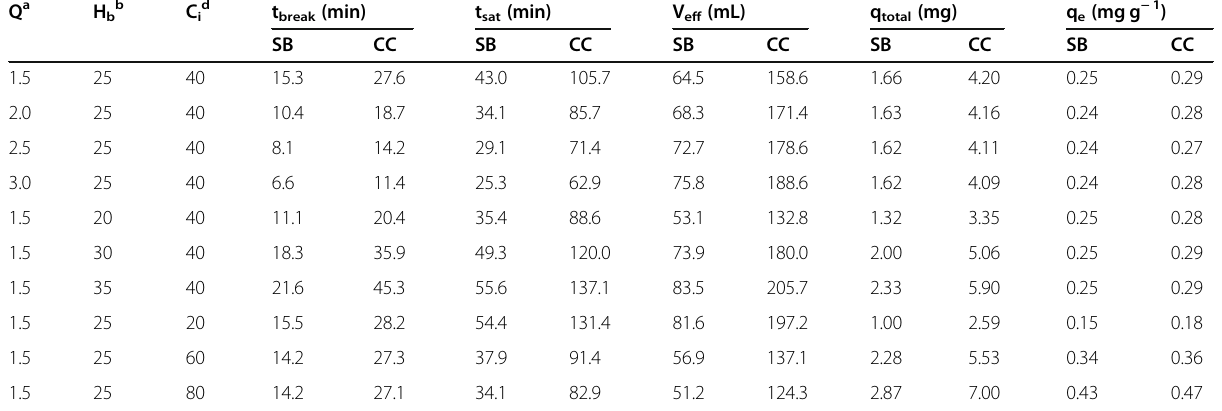
Table 3 Column parameters obtained at various flow rates, inlet concentrations, and bed heights Q a